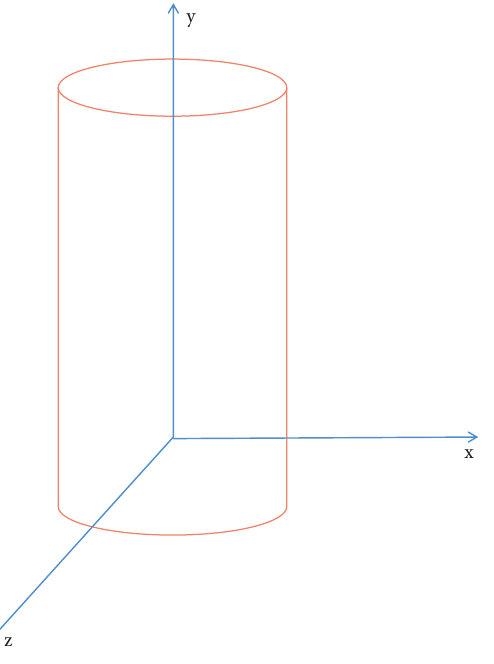
Figure 5: Ceramic sculpture coordinate system.